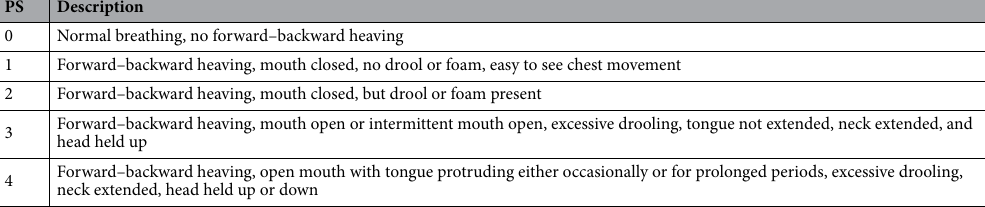
Table 1. The respiratory dynamic and panting score (PS) of